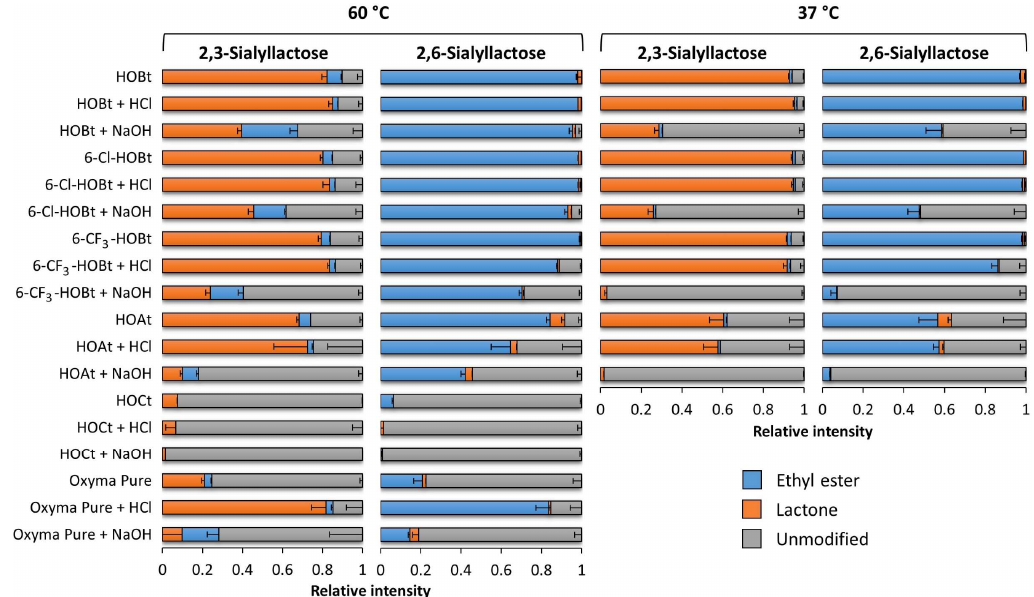
Figure 4. Ethyl esterification and lactonization, induced on the SL standards by the catalysts at different pH and temperatures. The catalysts were evaluated under native, acidic, and basic conditions at 60 °C (left panel) and 37 °C (right panel). All conditions were incubated for 1 h in ethanol, in the presence of EDC and one of the catalysts. The name of the catalyst without indication: native (pH 6), + HCl: acidified (pH 3), + NaOH: basified (pH 9). Shown are the average (stacked bars) and standard deviations (error bars) for triplicate measurements. Total area normalization was performed on modified and unmodified sialyllactose forms with the gross composition: hexose (H)2, N-acetylneuraminic acids (S)1 and their different sialic acid linkage variants H2L1 and H2E1 (lactonized α2,3-sialic acid: L; ethyl esterified α2,6-sialic acid: E). Additional information on spectra quality is included as